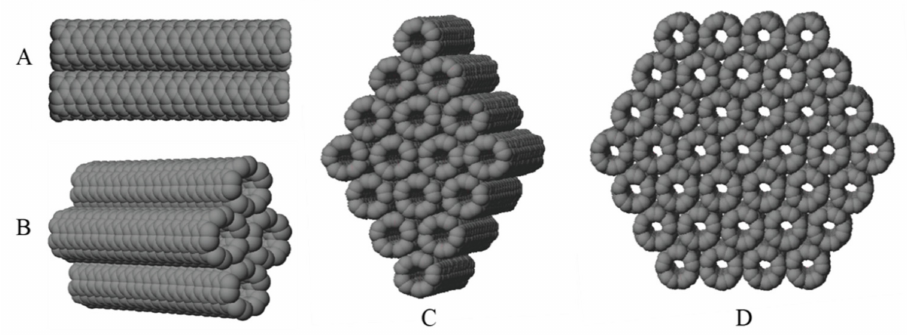
Figure 2. Collections of carbon nanotubes (CNTs) are shown: ( A ) a pair with one pair interaction, ( B ) a group of four CNTs with five pair interactions, ( C ) a diamond-shaped bundle of 16 CNTs with 33 pair interactions, and ( D ) a hexagon-shaped bundle of 37 CNTs with 90 pair interactions.